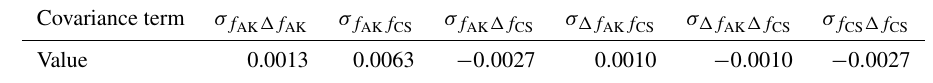
Table 2. Covariances between terms for snow depth uncertainty